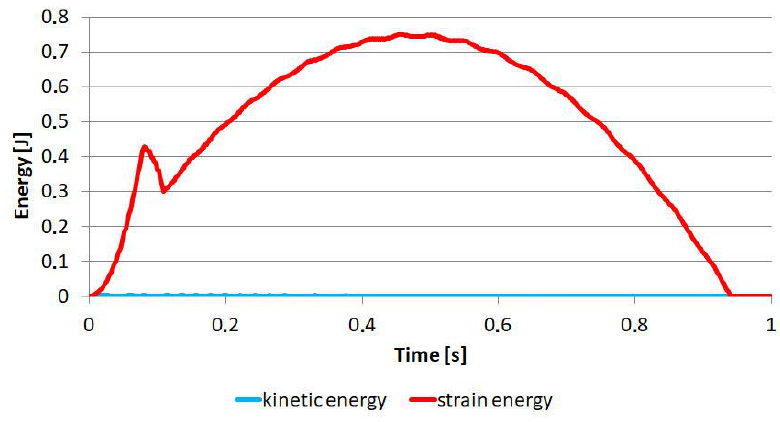
Figure 6. The change of energy over time.